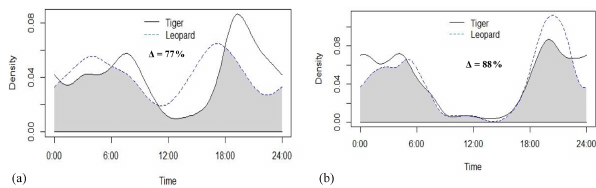
Figure B5. Activity curves and extent of temporal overlap between tiger and leopard in (a) 2014 and (b) 2015 in Pench Tiger Reserve, Madhya Pradesh.